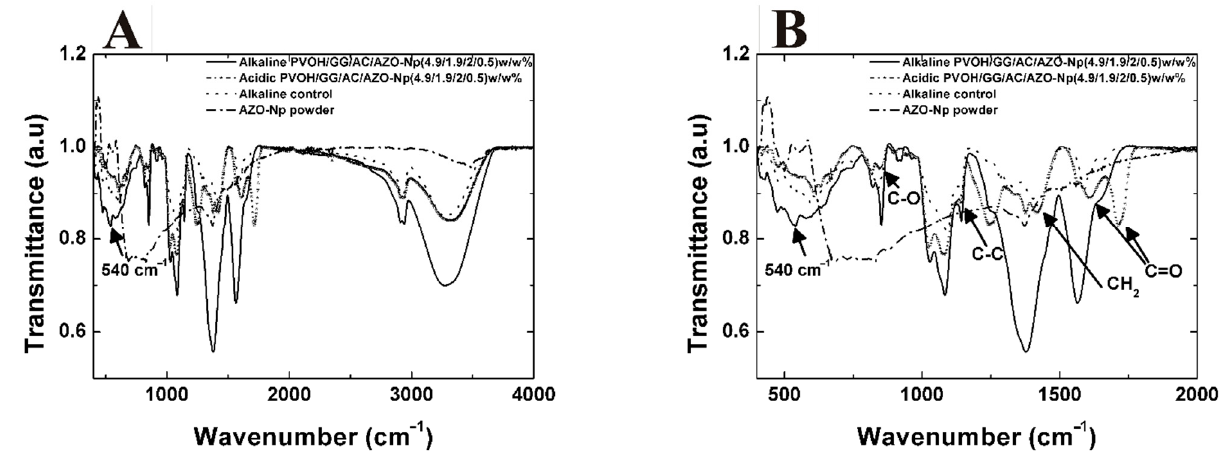
Figure 6. ( A ) ATR spectra of samples alkaline PVOH/GG/CA/AZO-Np (4.9/1.9/2.0/0.5) ( w / w ) %, acidic PVOH/GG/CA/AZO-Np (4.9/1.9/2.0/0.5) ( w / w ) %, alkaline control, AZO-Np nano-powder, (400–4000 cm − 1 ). ( B ) Same sample transmittance spectra zoom (400–2000 cm − 1 ).